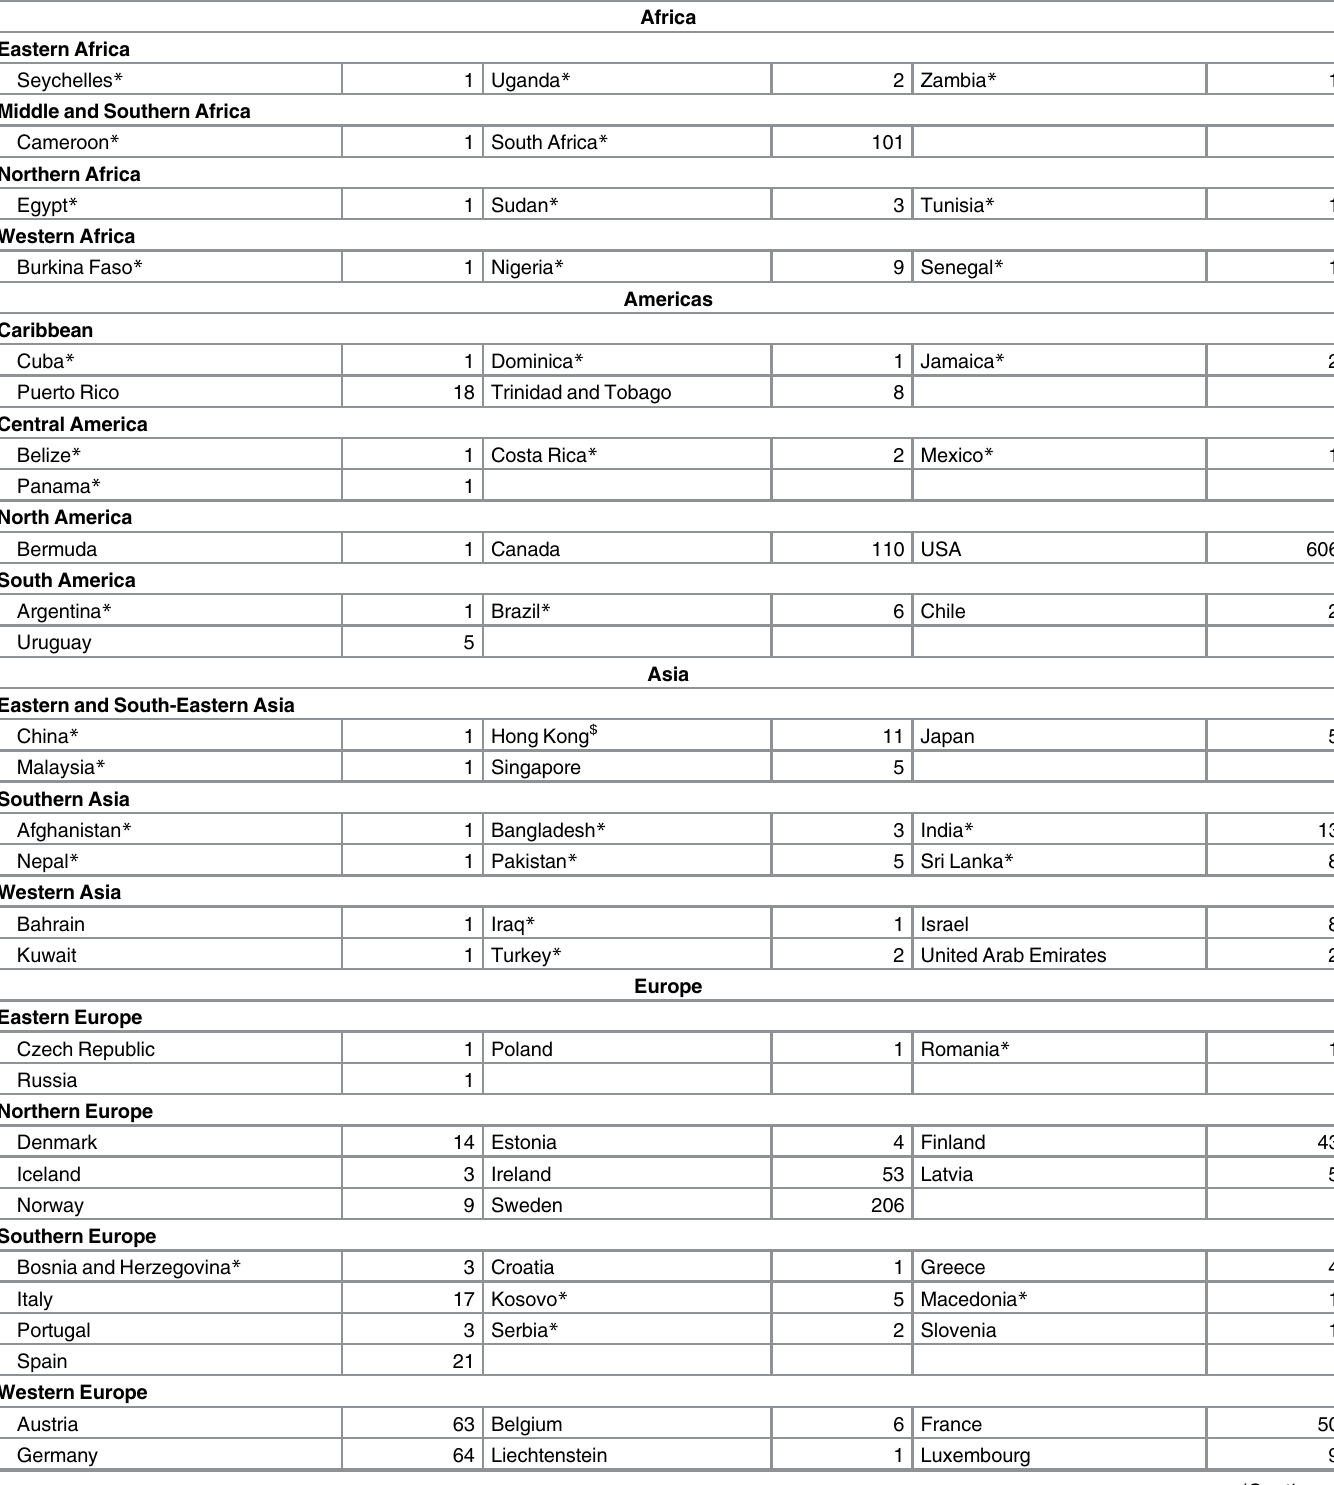
Table 2. Respondents place of work, according to the UN classification of continent and country. Developed countries were those considered high income in IMF classification (n = 1576), and developing countries were those belonging to the remaining 4 IMF classification categories (n = 186). Only data from clinician respondents were